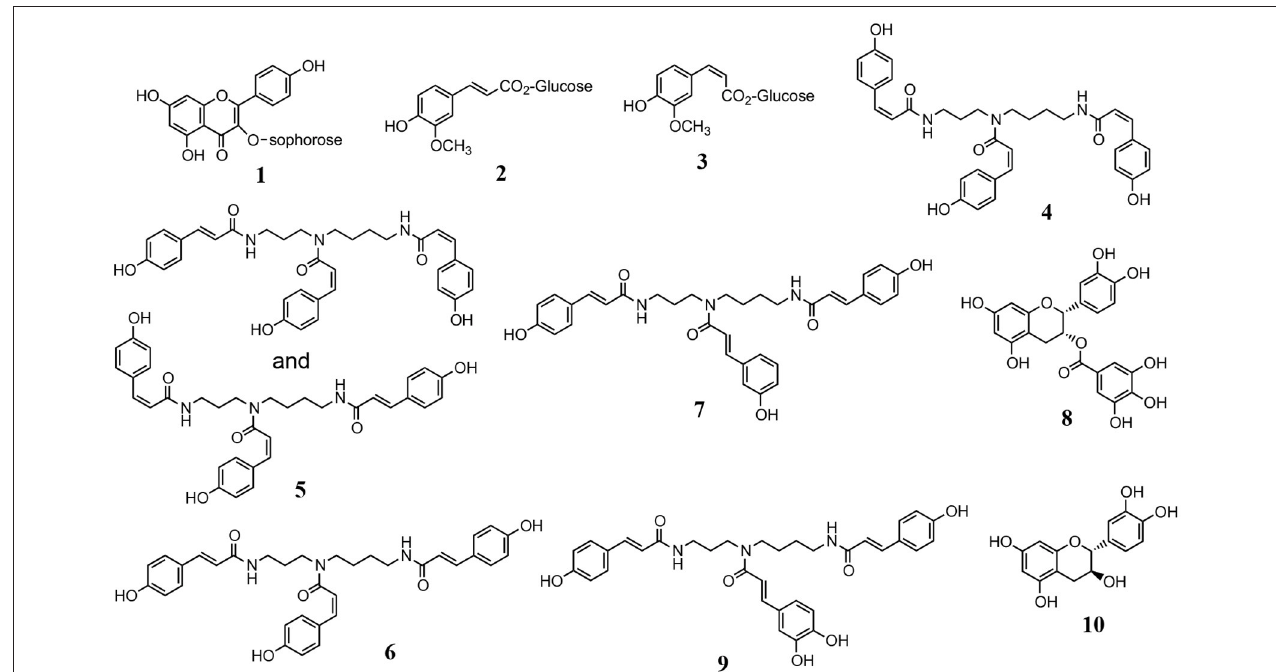
FIGURE 7 | Compounds from peach pollen ( 1–7 ) and tea pollen ( 6–10